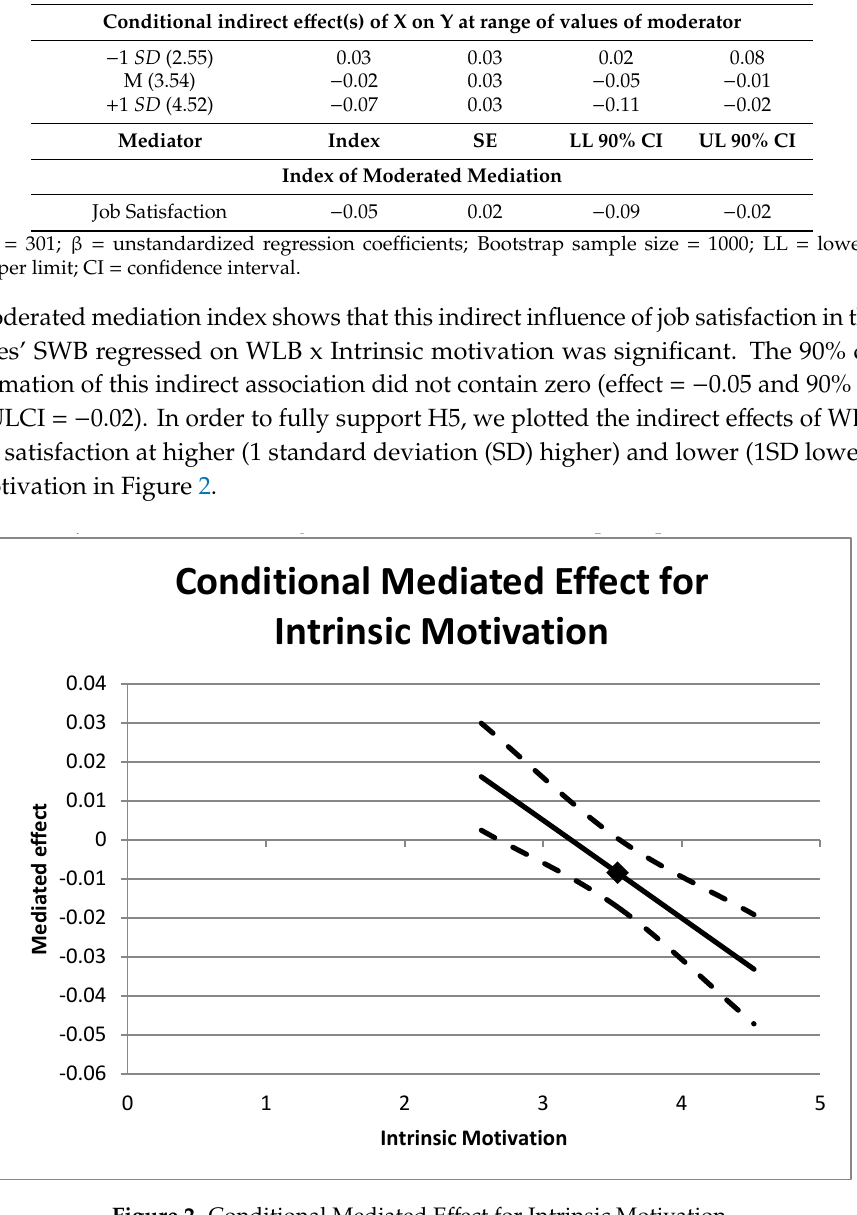
Figure 2. Conditional Mediated Effect for Intrinsic Motivation.